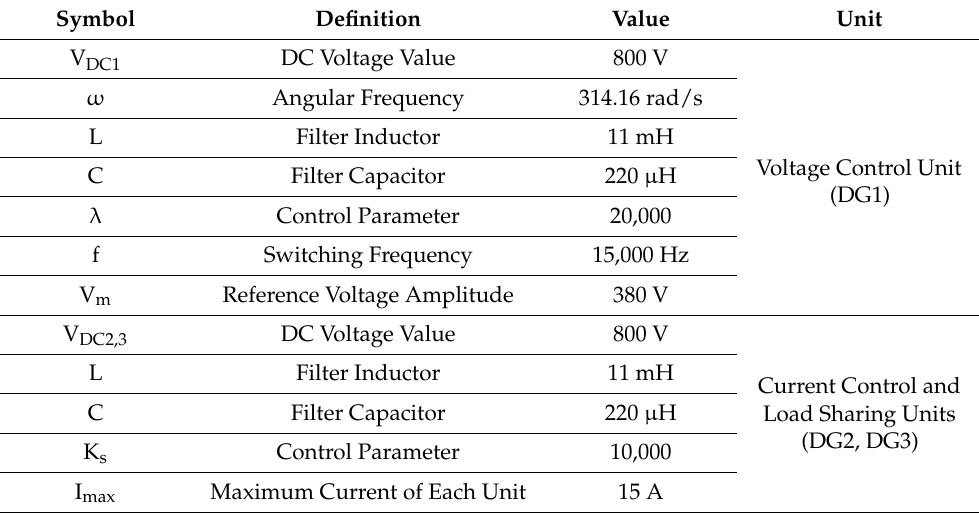
Table 2. Values of Distributed Generation Source and Control Parameters.